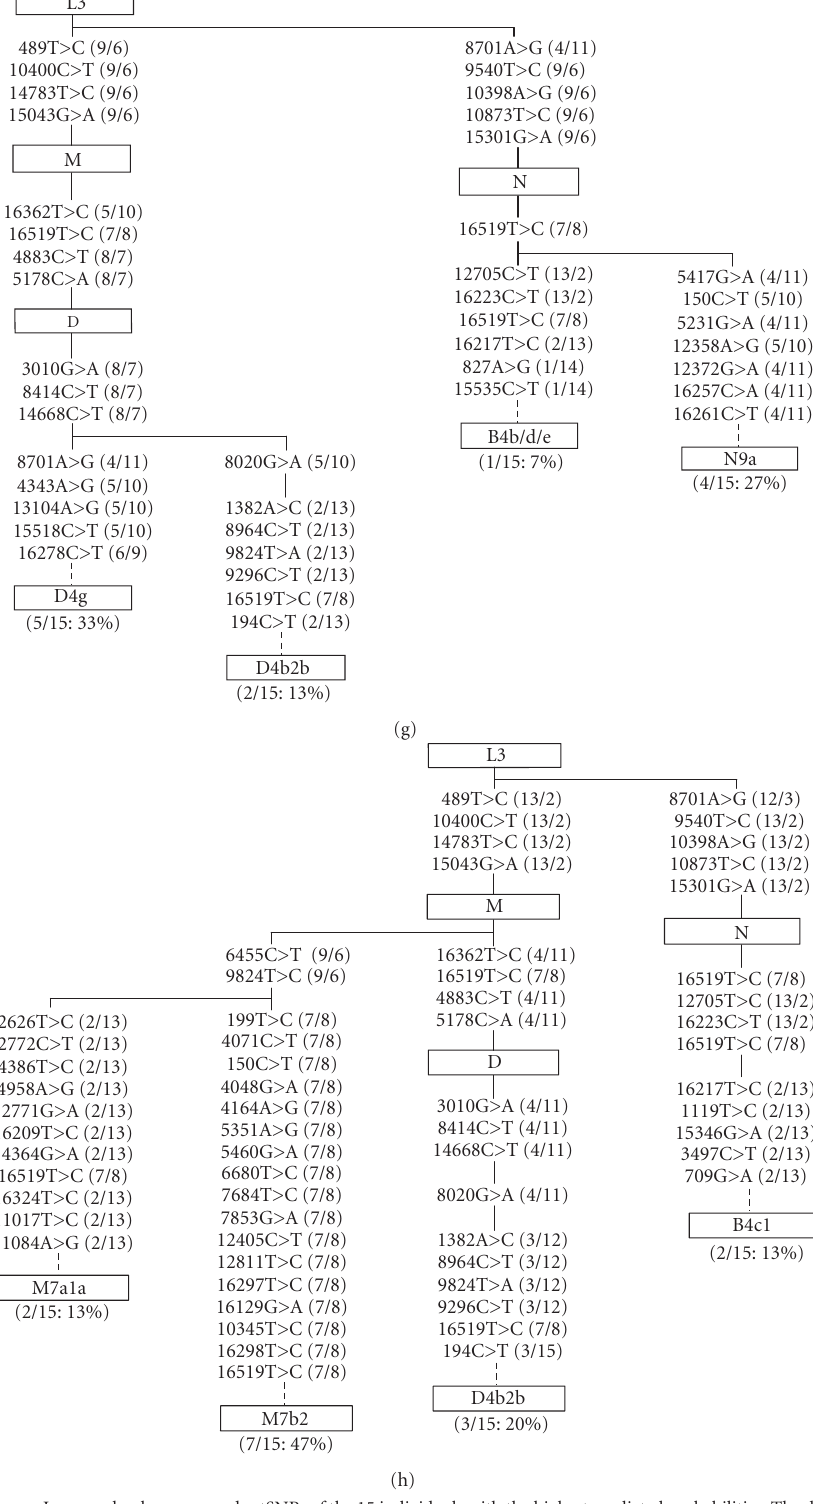
Figure 2: Associations between Japanese haplogroups and mtSNPs of the 15 individuals with the highest predicted probabilities. The description of the associations between Japanese haplogroups and mtSNPs is based on the phylogenetic tree for macrohaplogroups M and N described in Tanaka et al. [26]. The locus of mtDNA polymorphism ( mmm ), normal nucleotide (rCRS) at the position mmm ( N N ), mtDNA mutation at the same position ( N M ), the number of the mtDNA mutations at mmm in individual highest clusters ( Y ), and the number of the normal nucleotides at mmm in individual highest clusters ( X ) are expressed as mmm N N > N M ( Y/ X ). In16362 T > C (9/6), for example, 16362is themtDNA locus,T is the normal nucleotide at position16362,Cis themtDNA mutation at that position,9 is thenumber of mtDNA mutations, and 6 is the number of the normal nucleotides. (a) Japanese AD patients, (b) Japanese PD patients, (c) Japanese T2D patients, (d) Japanese T2D patients with angiopathy, (e) Japanese centenarians, (f) Japanese semi-supercentenarians, (g) Japanese non-obese young males, and (h) Japanese obese young